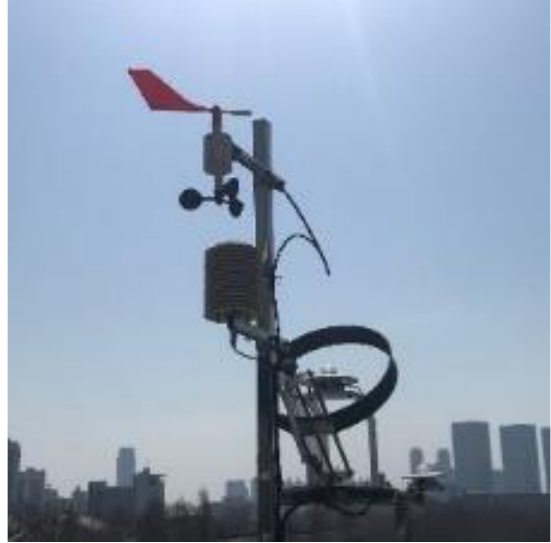
Figure 6. Local weather station. Table 2. The sensor information of the weather